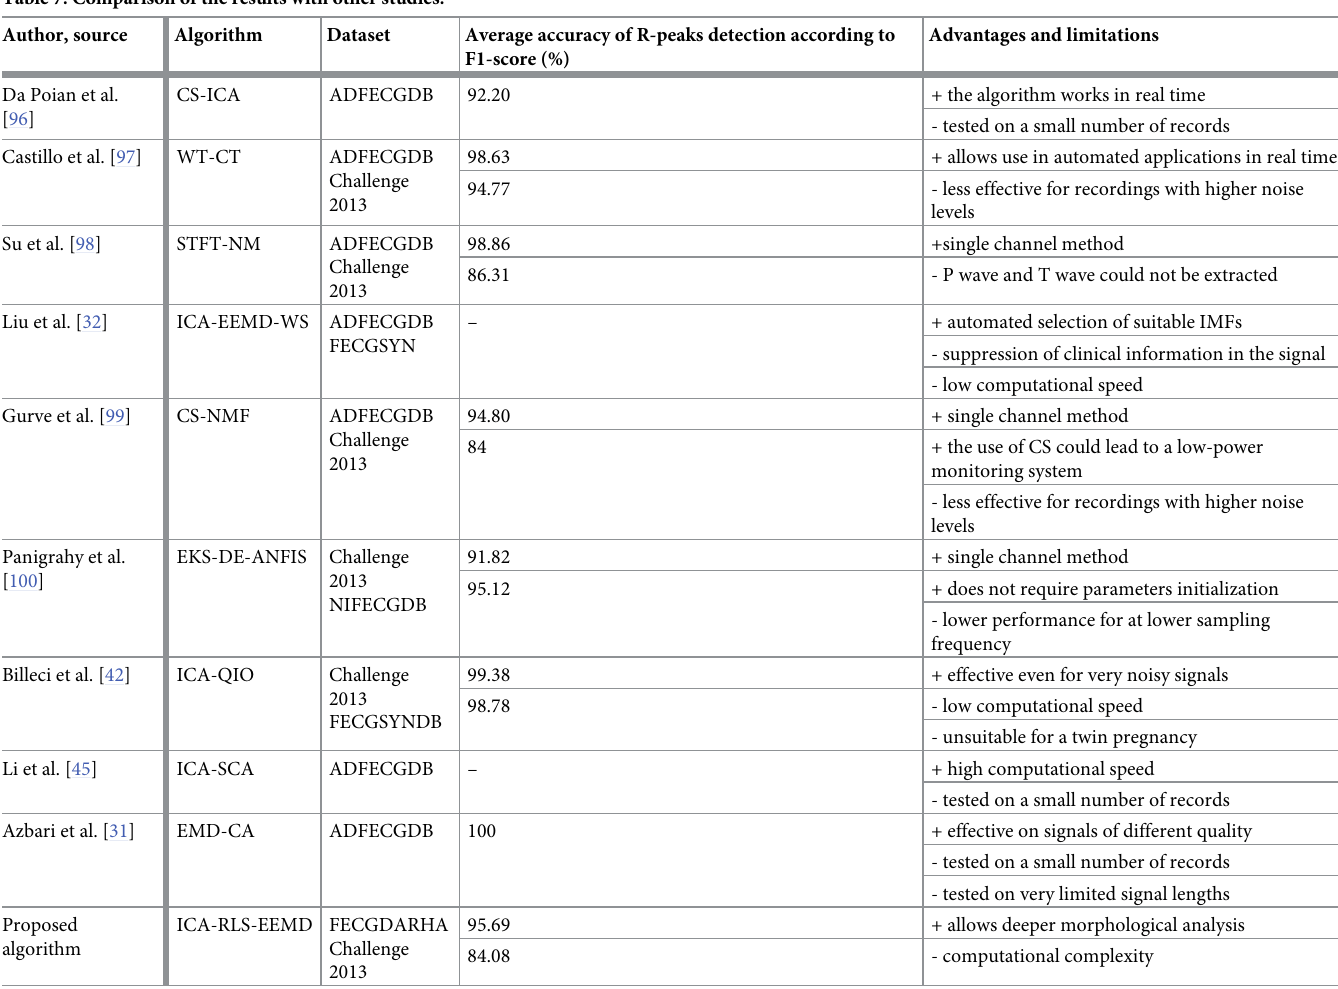
Table 7. Comparison of the results with other